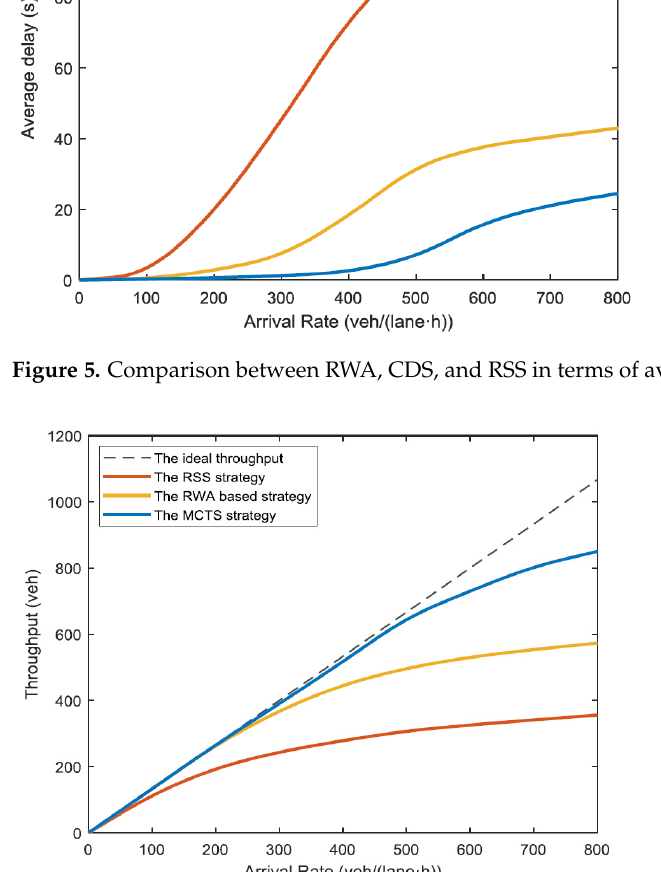
Figure 6. Comparison between RWA, CDS, and RSS in terms of throughput/arrival rate